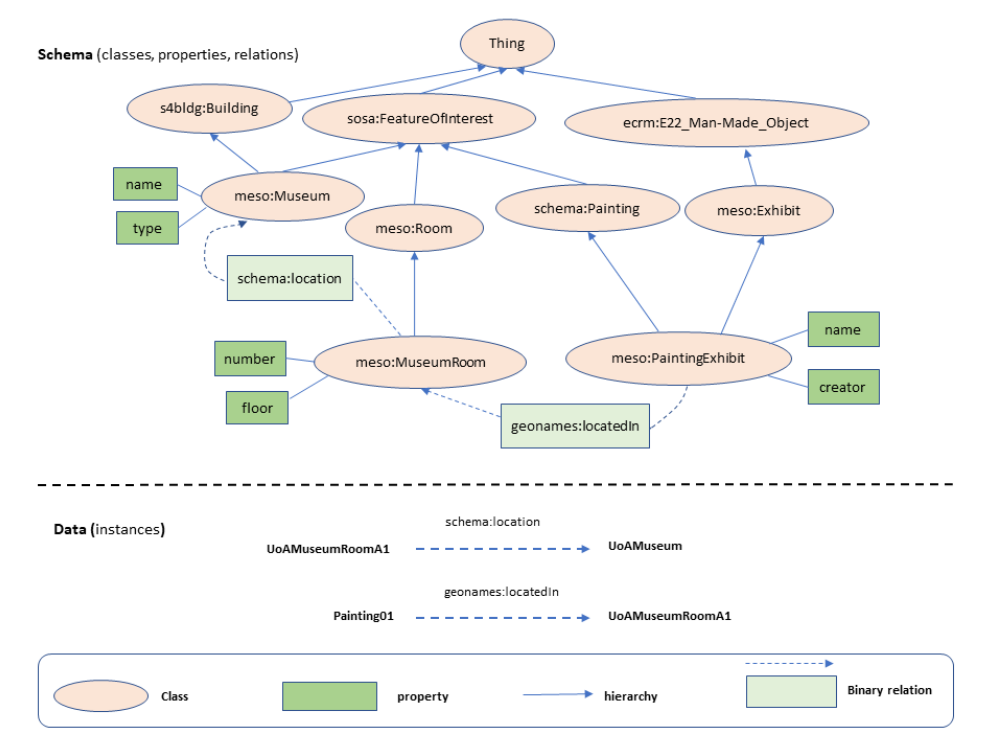
Figure 1. Simple example ontology for the museum